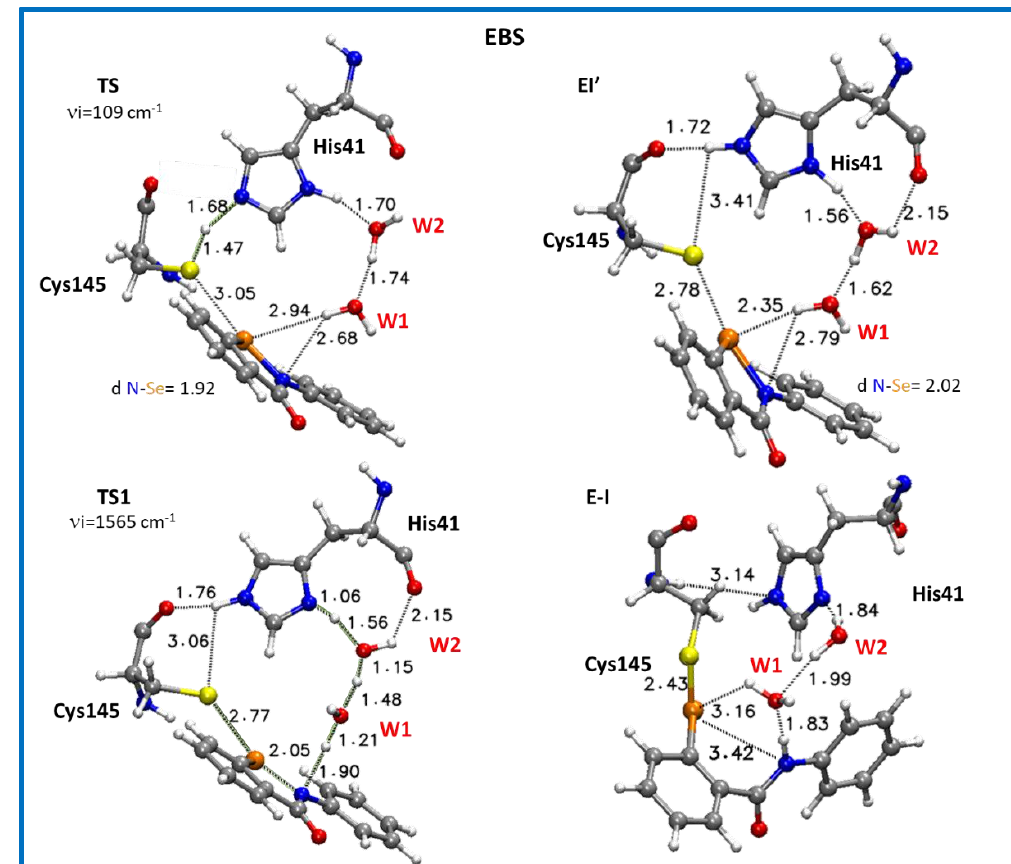
Figure 6. B3LYP-D3/6-31+G (2d,2p) free energy profiles of M pro SARS-CoV-2 covalent inhibition mechanism by EBS and EBS-OH in two phases: activation and inhibition through covalent bond formation, expressed in kcal mol −1 . Solid line indicates calculations in water ( ε = 80) and dotted line in the protein environment ( ε = 4).